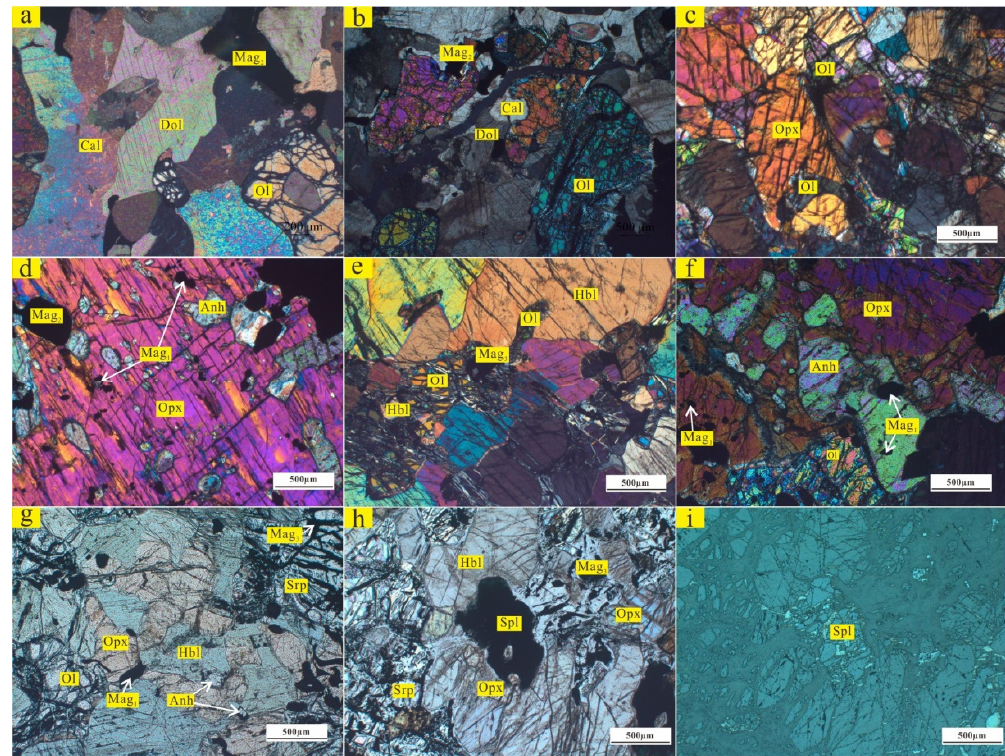
Figure 4. The mineral assemblages of the different types of wall rocks in the Zhaoanzhuang iron deposit. ( a ) Olivine–dolomitic marble with magnetite. ( b ) Olivine–dolomitic marble with magnetite. ( c ) Olivine–orthopyroxenite. ( d ) Tabular orthopyroxene contains abundant anhydrite and minor magnetite (Mag 1 ) inclusions. ( e ) Olivine–amphibolite. ( f ) Olivine–orthopyroxenite with residual anhydrite. ( g ) Olivine–orthopyroxene-amphibolite. ( h , i ) Olivine–amphibolite